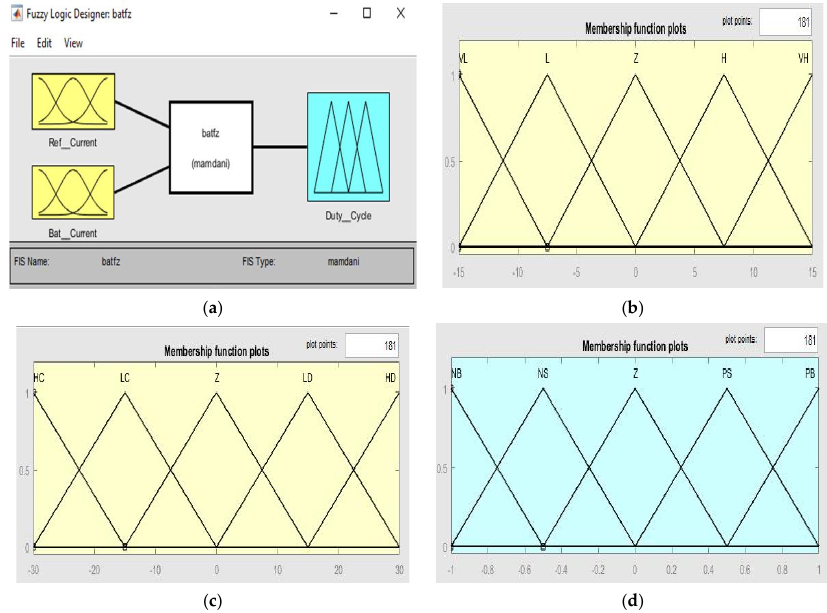
Figure 17. FLC of auxiliary battery. ( a ) Fuzzy inference system for OSSC; ( b ) reference current; ( c ) battery current; and ( d ) duty cycle. ‘Error Ref’ (error signal) and ‘Supercapacitor Current’ were the inputs of the FLC, and ‘Duty Cycle’ was the output of the FLC. The membership functions of inputs of the SC FLC were set based on Figure 18a. The membership functions of ‘Error Ref’ were set as ‘Very Low’ ( − 15 to − 7.5), ‘Low’ ( − 15 to 0), ‘Zero’ ( − 7.5 to 7.5), ‘High’ (0 to 15), and ‘Very High’ (7.5 to 0), as shown in Figure 18b. The membership functions of ‘Supercapacitor Current’ were set as ‘High Charging’ ( − 30 to − 15), ‘Low Charging’ ( − 30 to 0), ‘Zero’ ( − 15 to 15), ‘Low Discharging’ (0 to 30), and ‘High Discharging’ (15 to 30), as shown in Figure 18c. The membership functions of ‘Duty Cycle’ were set as ‘Negative Big’ ( − 1 to − 0.5), ‘Negative Small’ ( − 1 to 0), ‘Zero’ ( − 0.5 to 0.5), ‘Positive Small (PS) (0 to 1), and ‘Positive Big (PB)’ (0.5 to 1), as shown in Figure 18d. Fuzzy rules for the battery and supercapacitor are shown in Tables 8 and 9.